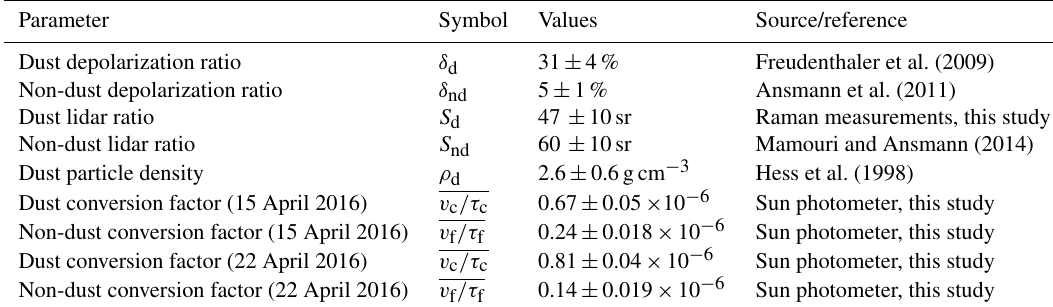
Table 1. Values of the input parameters used in the POLIPHON algorithm.